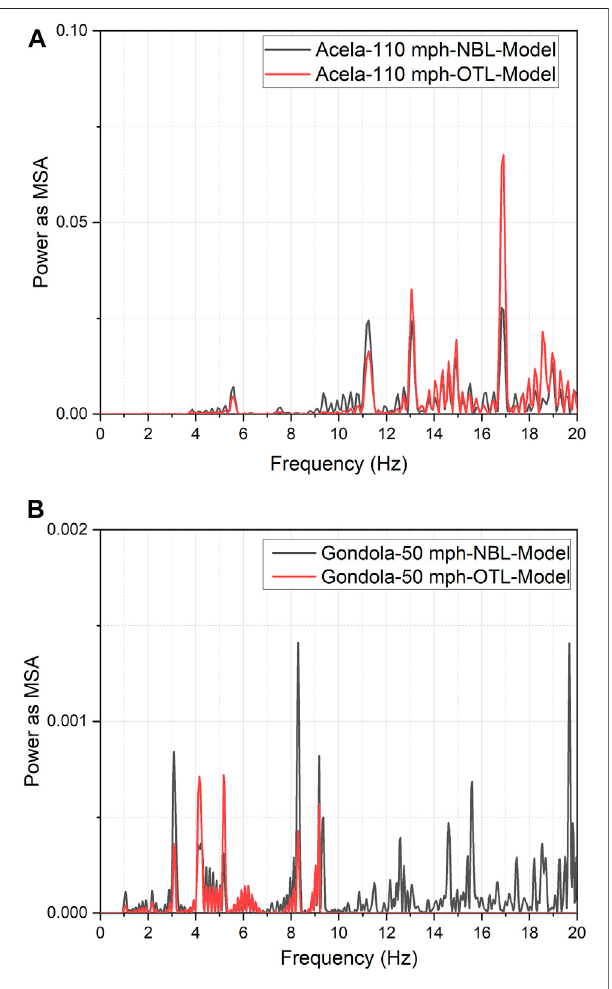
FIGURE 12 | Frequency aomain analysis of tie acceleration under the passage of (A) Amtrak ’ s Acela Express train moving at 177 km/h; (B) A train set comprising gondola cars moving at 80.5